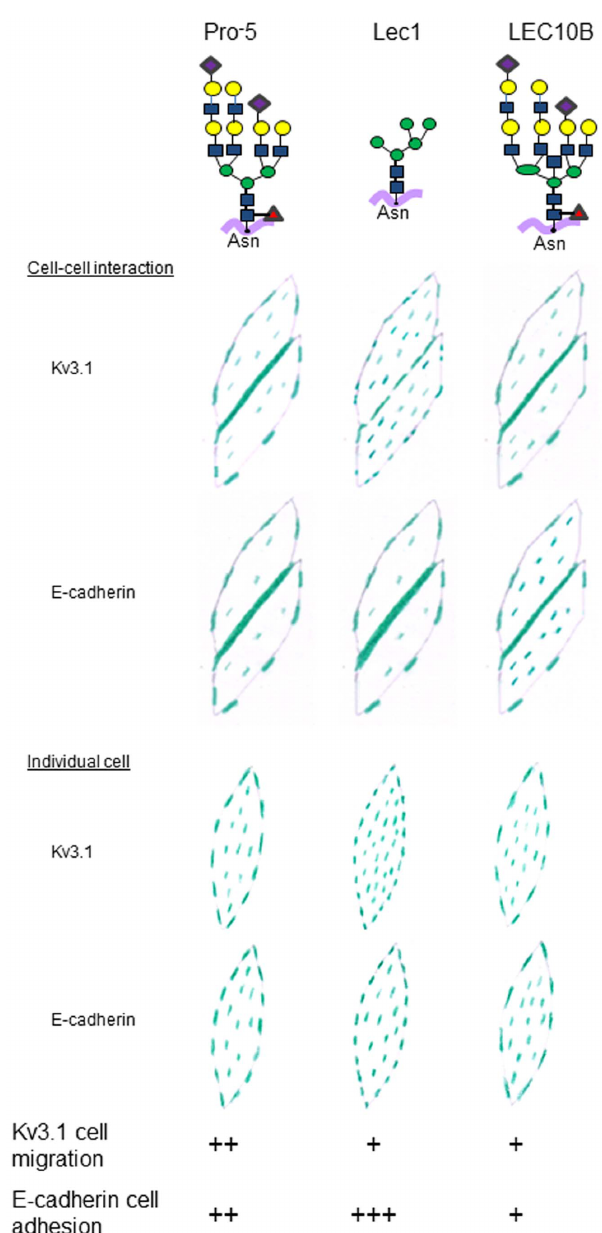
Figure 7. Model depicting the information encoded by glycan structures of Kv3.1 and E-cadherin. Top drawings show predom- inant glycans present in each CHO cell line studied [14]. In the cell drawings, green dashes denote the relative amounts of GFP tagged Kv3.1 or E-cadherin particles in the adhered membrane of interacting (Figure 3) and non-interacting (Figure 4) cells. The relative effects of the glycoproteins on cell migration (Figure 5) and cell adhesion (Figure 6) are shown with (x) signs.